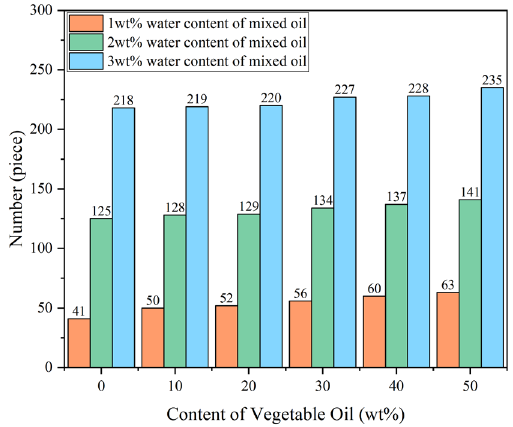
Figure 6. The number of H-bonds in each mixed oil model.